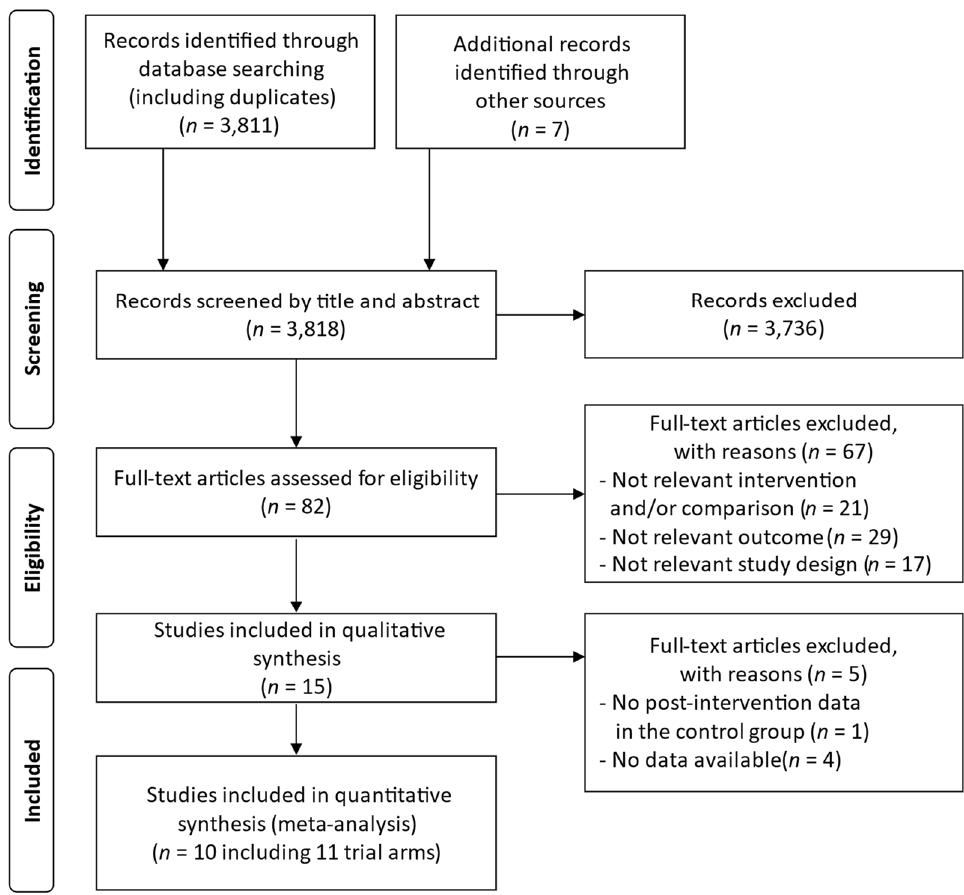
Figure 1. Flow diagram of the study selection process. Table 1. Quality assessment of the selected studies.